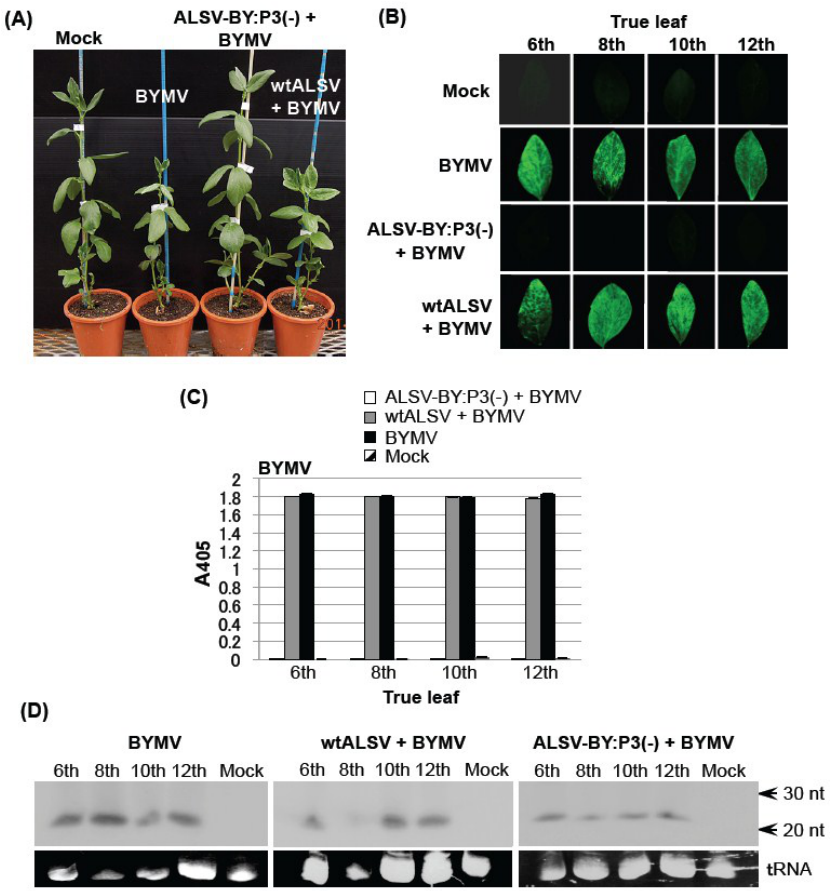
Figure 3. Protective effects of pre-inoculating broad bean plants with an Apple latent spherical virus (ALSV) vaccine (ALSV-BY:P3(−)) on challenge inoculation with a Bean yellow mosaic virus (BYMV) expressing green fluorescent protein (GFP). ( A ) Symptoms of broad bean plants inoculated with BYMV only, co-inoculated with the ALSV vaccine and BYMV, or wtALSV and BYMV at 21 days post-inoculation (dpi); ( B ) Fluorescence microscopy of the sixth to 12th true leaves of broad bean plants co-inoculated with ALSV-BY:P3(−) and BYMV; ( C ) Enzyme-linked immunosorbent assay (ELISA) measuring BYMV accumulation in the sixth to 12th leaves of the broad bean shown in ( B ); Leaf samples were collected at 21 dpi with BYMV. In both ALSV vaccine + BYMV and wtALSV + BYMV plots, ELISA values of ALSV in the sixth to 12th leaves were approximately 1.8 (data not shown); ( D ) Northern blot analysis of the small interfering RNAs derived from the BYMV-P3 regions of the sixth to 12th leaves of broad bean plants inoculated with BYMV only, co-inoculated with wtALSV and BYMV, or co-inoculated with the ALSV vaccine and BYMV. Low molecular weight RNA was extracted from the sixth, eighth, 10th, and 12th leaves of the BYMV, wtALSV + BYMV, and ALSV-BY:P3(−) + BYMV groups, and northern blotting was performed, using RNA complementary to the P3 region of the BYMV genome as a probe [8]. siRNAs derived from BYMV-RNA were found in all leaves of the BYMV, wtALSV + BYMV, and ALSV-BY:P3(−) + BYMV groups (Figure